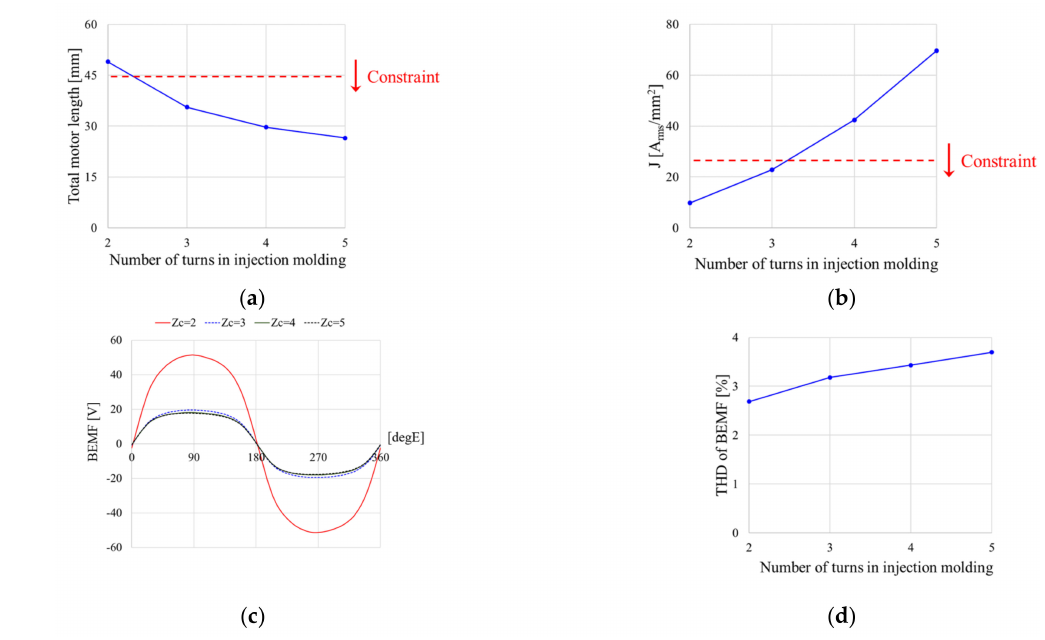
Figure 8. Characteristics for the number of turns in injection molding: ( a ) total motor length; ( b ) current density; ( c ) BEMF waveform; ( d ) THD of